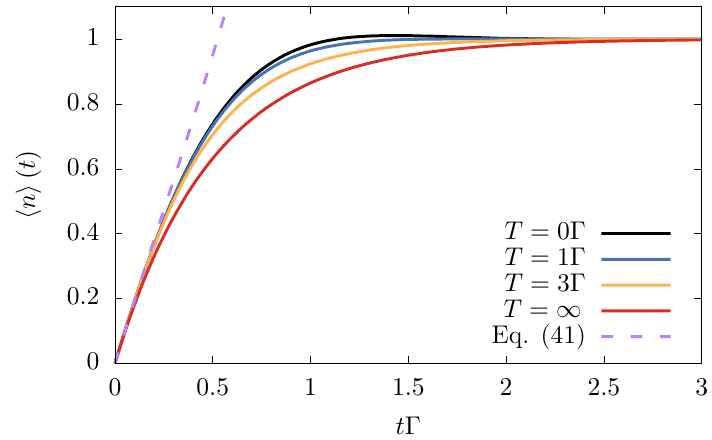
Figure 3: Transient occupation 〈 n 〉 ( t ) for U = 4 Γ , ε = − U / 2, bias V = Γ and sev- eral temperatures. Initially the dot is empty, ρ contributions of Eq. (41) are negligible here, but can play a role, see Fig.